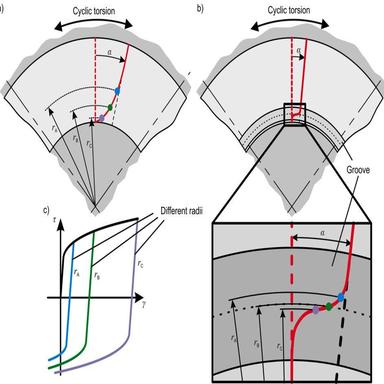
Method to simultaneously determine multiple stress-strain curves with a single in-plane torsion test (a) planar in-plane torsion specimen (b) specimen with groove and (c) radius-depending cyclic stress-strain curves (color should be used in print).